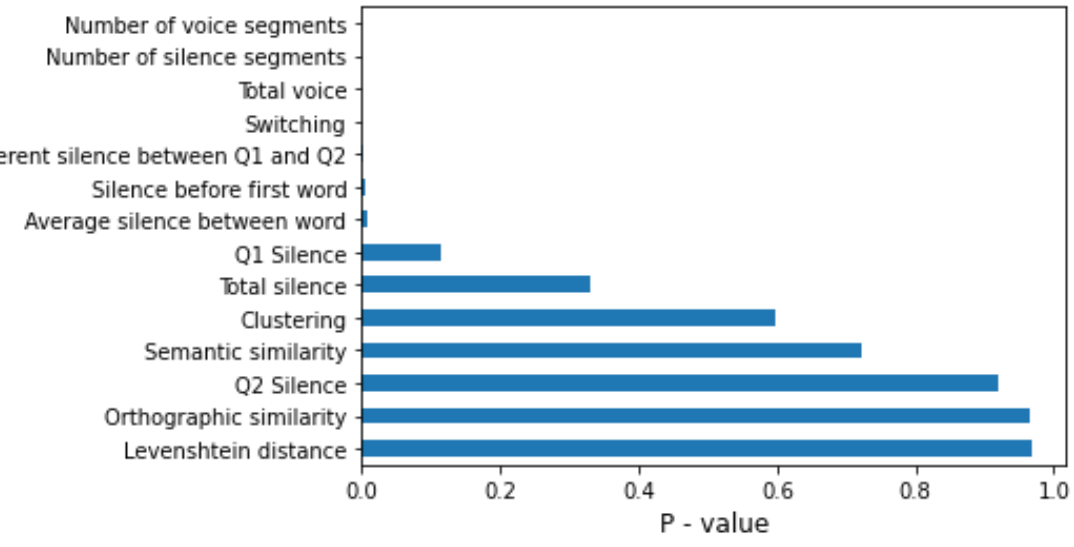
Figure 7 . Feature importance explained by the SHAP value for the SVM classifier.